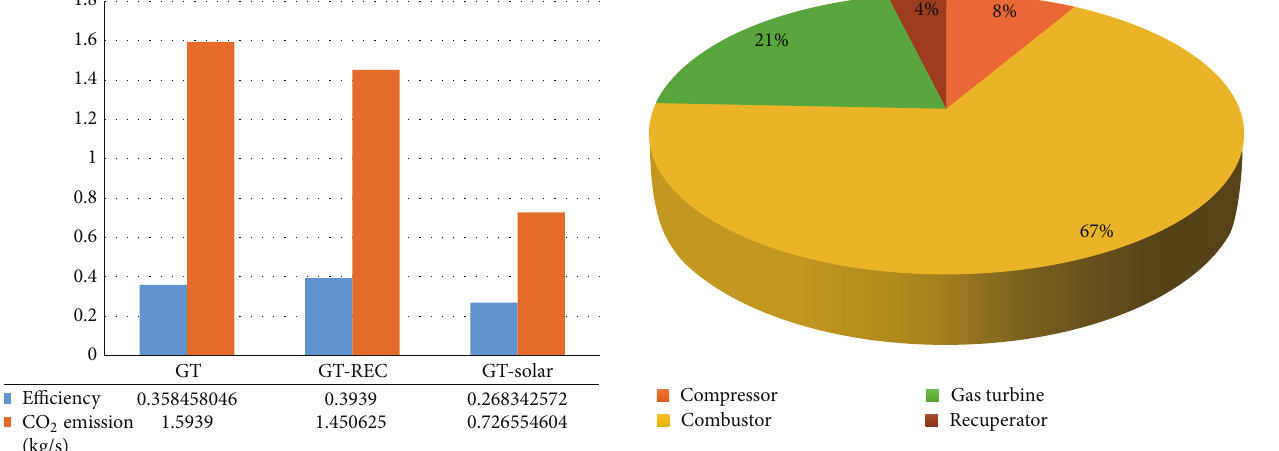
Figure 2: Efficiency-emission for different scenarios.